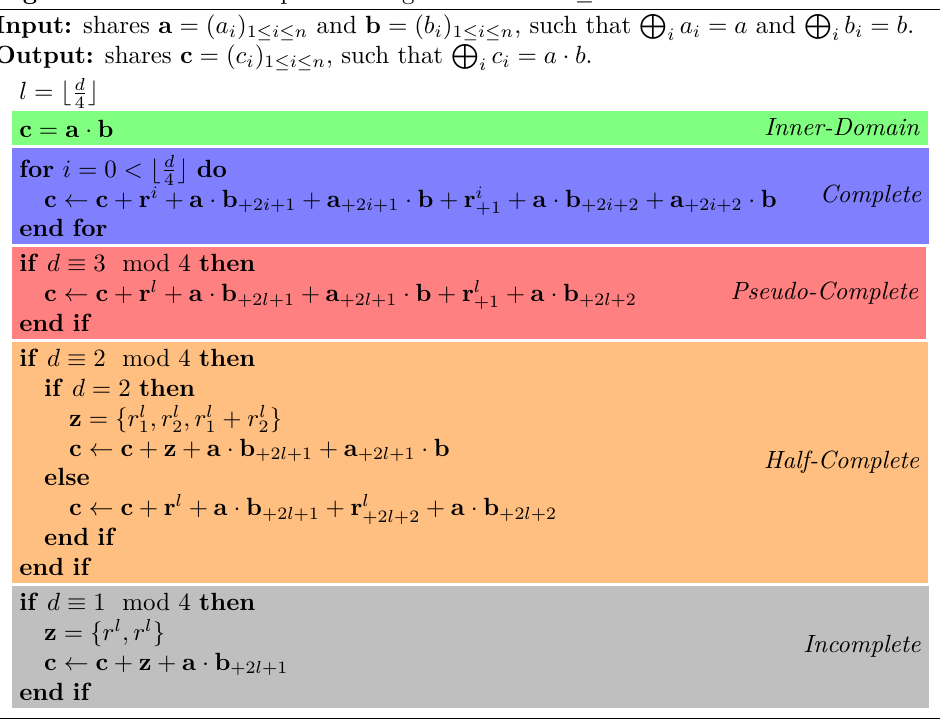
Algorithm 3 UMA multiplication algorithm with n ≥ 1